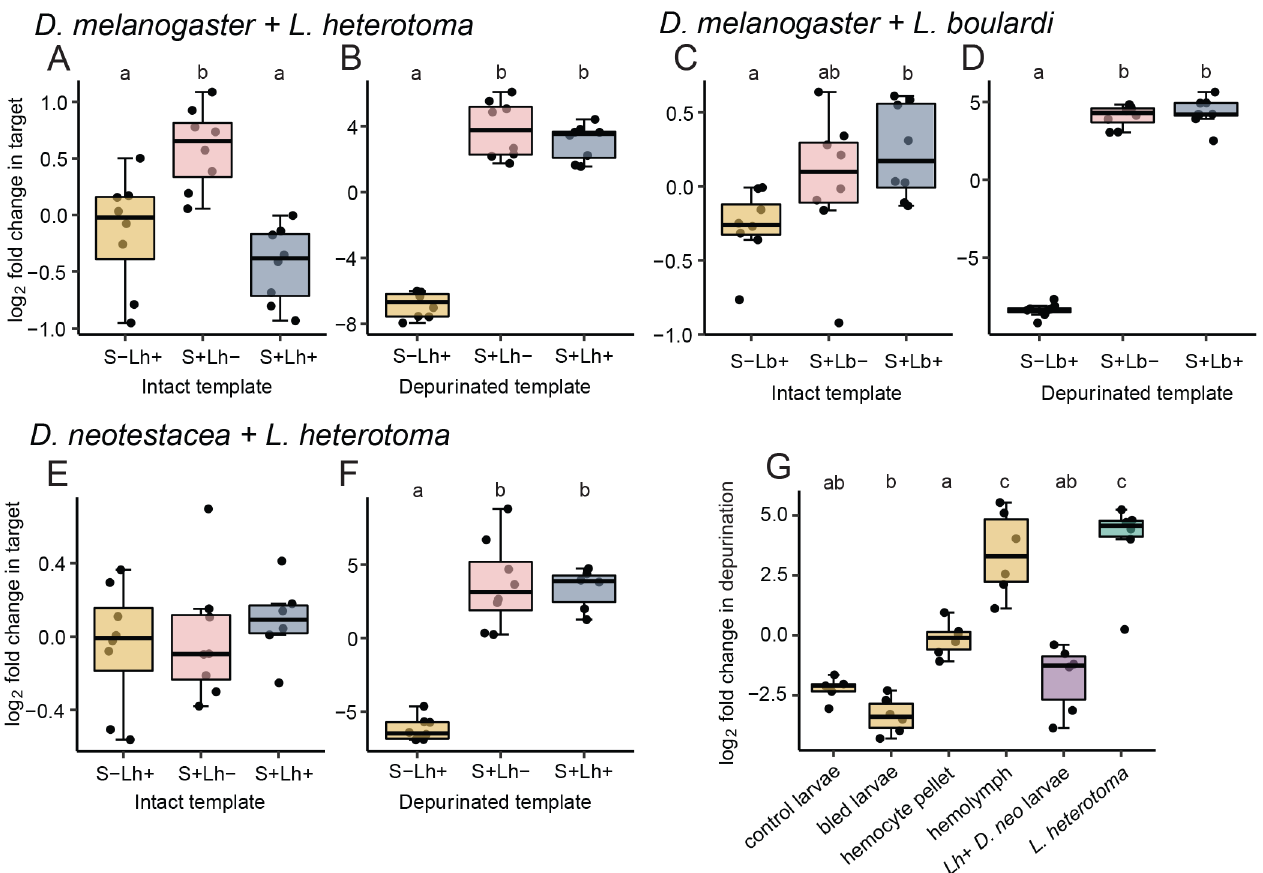
Fig 3. Depurination of Drosophila ribosomes is minimal and does not explain host mortality during parasitic wasp infestation. Levels of intact Drosophila ribosomes are not significantly decreased in Spiroplasma -positive flies (blue), comparedto Spiroplasma -negativeflies (gold) (A, C,E; p = .348, p = .026, p = .693 for L . heterotoma -infested D . melanogaster , L . boulardi -infested D . melanogaster and L . heterotoma -infested D . neotestacea , respectively). Depurinated Drosophila ribosomes are significantly more abundantin Spiroplasma -positive(blue) comparedto Spiroplasma -negativeflies (gold; B,D,F; p < .001); however, there is no difference in abundance of depurinated Drosophila ribosomes between wasp-infested (blue) and uninfestedhosts (pink) regardlessof fly survival outcome followingdefense. Jitter points are the mean of two technical replicatesper larva. (G) Levels of depurinated Drosophila ribosomes are plotted for samplesof host hemolymph, hemocytes, bled larvae and unbledcontrols. Jitter points are the mean of two technicalreplicates per pool of eight larvae. The proportionof depurinatedhost and infesting wasp ribosomes from larvalsamples collectedin a separate experiment are shown for comparison. Post hoc significancetest results are shown above boxplots(Tukey tests).